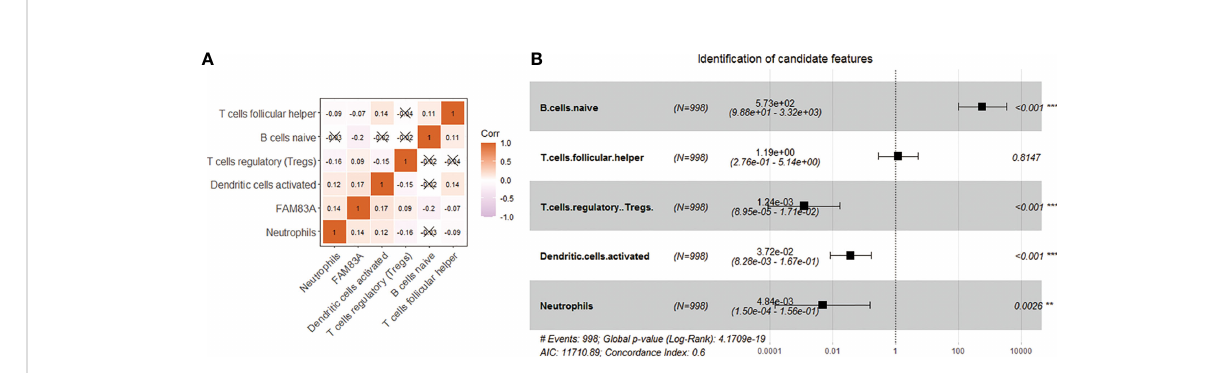
FIGURE 5 Use correlation analysis to fi lter features. (A) Correlation graph between the in fi ltration level of 5 immune cells and the expression level of FAM83A gene. (B) Five kinds of immune cells and FAM83A related forest plot. **p<0.01, ***p<0.001.